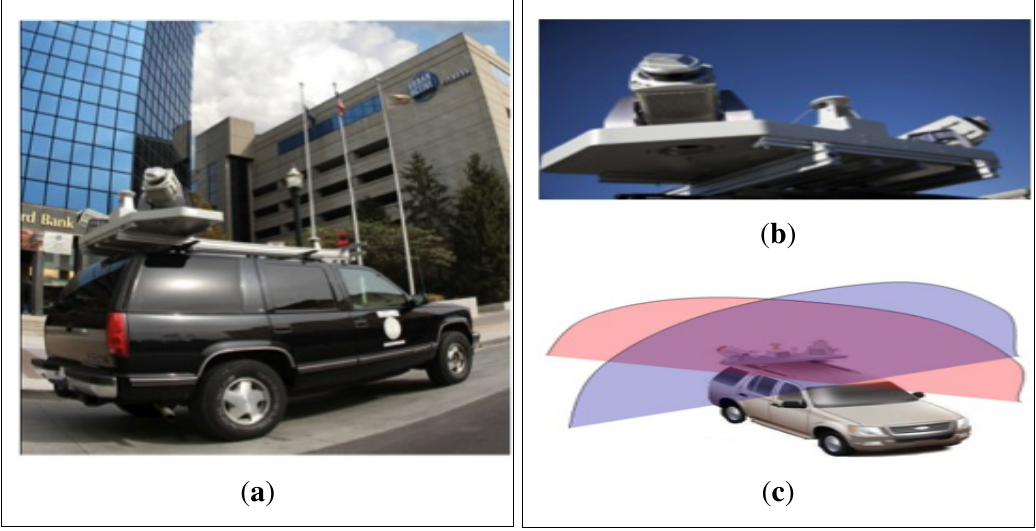
( a ) The Vis Center’s LiDAR truck; ( b ) Optech LiDAR/GPS system along with IMU mounted on a rigid frame; ( c ) the different viewing angles of the mounted LiDAR